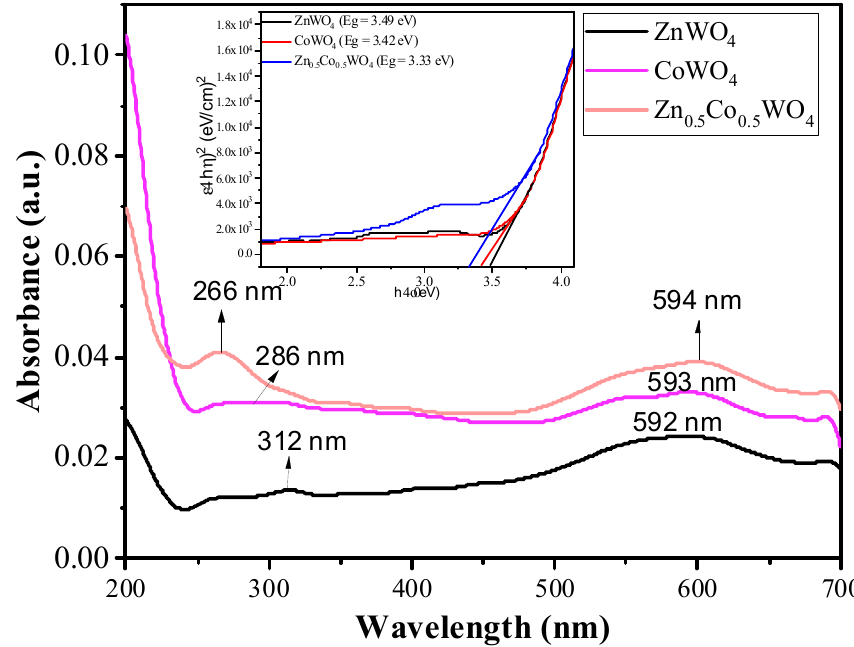
Figure 5. UV–vis plot of ZnWO 4 NPs, CoWO 4, and Zn 0.5 Co 0.5 WO 4 in the wavelength range of 200–700 nm (inset is the Tauc’s plot for calculating the band gap energy (E g ) of the material). Figure 6 consists of the photoluminescence emission spectra of ZnWO 4 , CoWO 4, and Zn 0.5 Co 0.5 WO 4 recorded at a 594 nm excitation wavelength. It can be seen that the PL spectra spans in the range of 545 to 575 nm with a prominent emission peak at 558 nm. The information obtained from the PL spectra suggested that the PL intensity of synthesized Zn 0.5 Co 0.5 WO 4 was found to be lower than that of ZnWO 4 and CoWO 4 . The inclusion of Co in the wolframite monoclinic structure of ZnWO 4 results in emissions due to the radiative transition between W and O in the WO 66 − molecular complex, which effectively slows down the electron–hole [33–35].